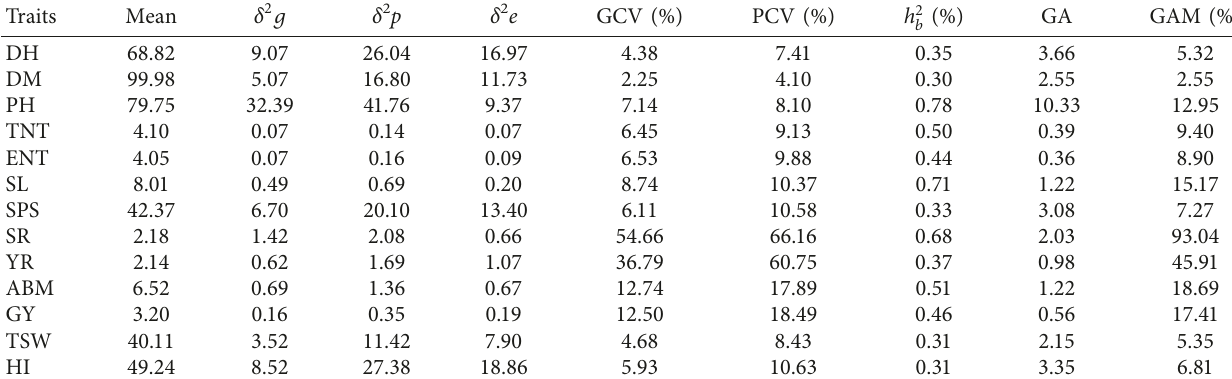
Table 10: Estimates of variance components at Damot Sore experimental